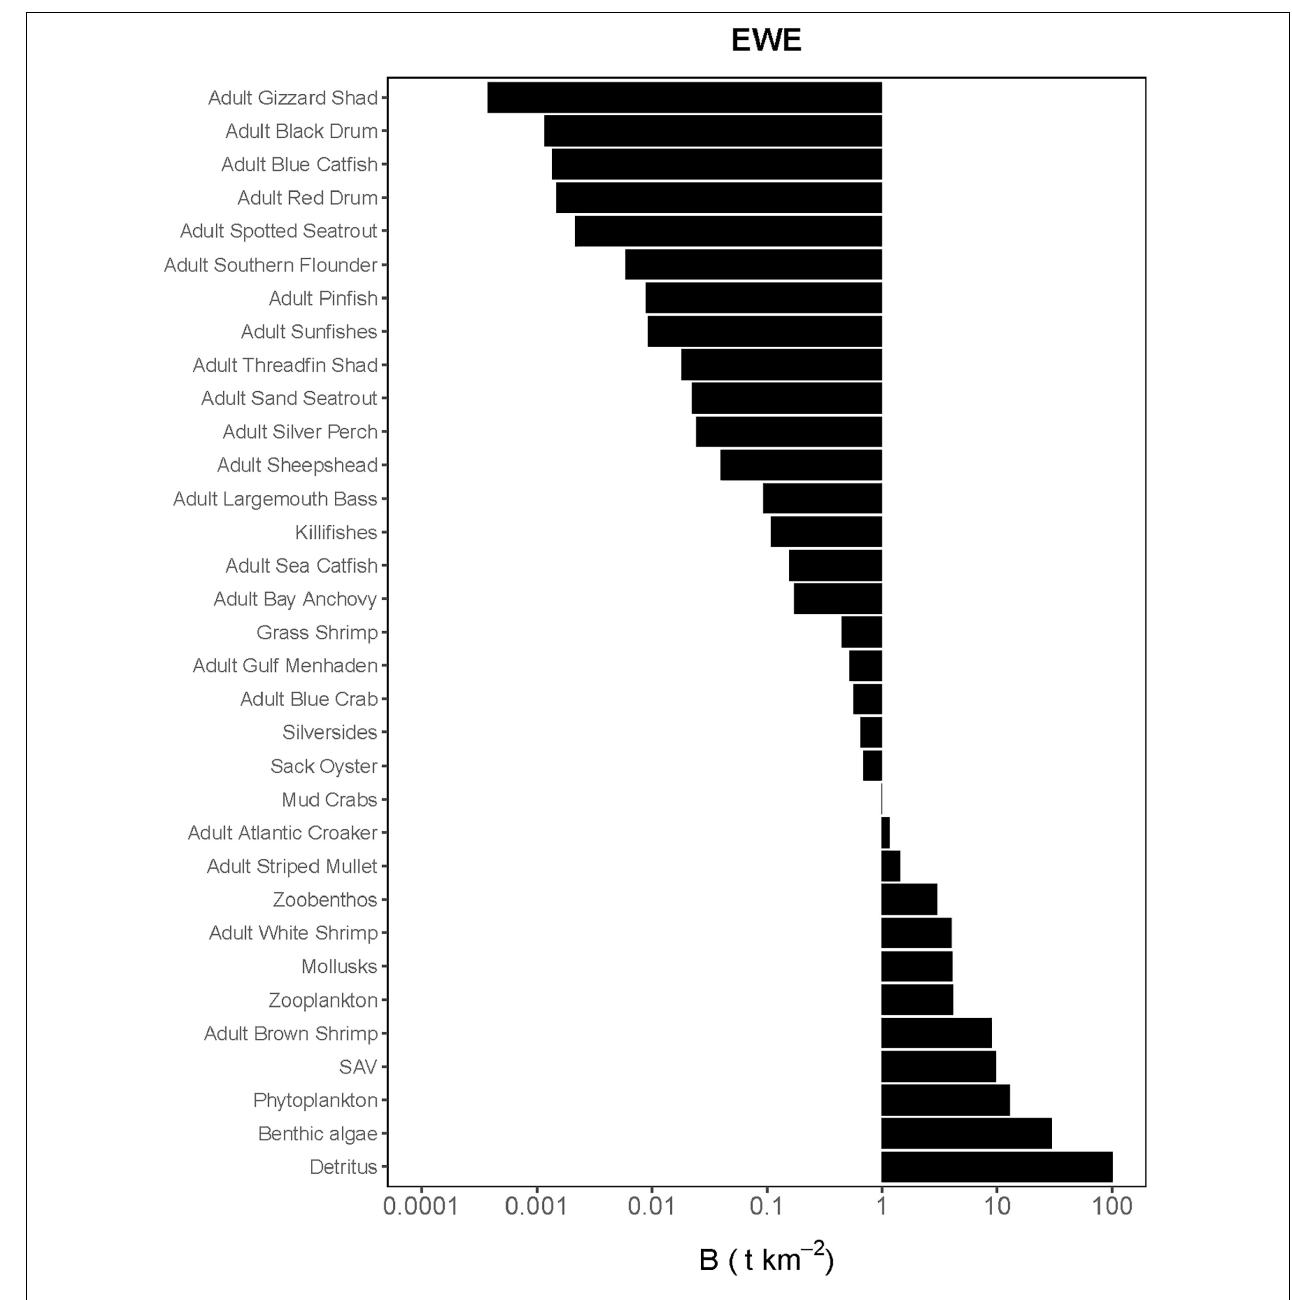
FIGURE 2 | Species-biomass distribution of the Ecopath base model used in the calibration simulation of Ecosim (plotted on log scale). EwE plot is only displaying adult life stages as biomasses for juveniles were calculated using von Bertalanffy (1933) growth model.